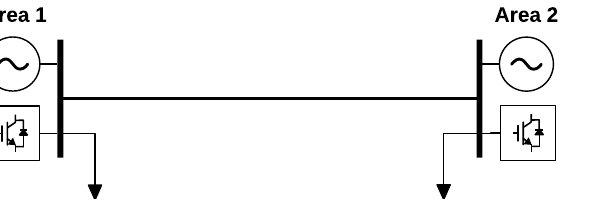
Figure 6. Generic two-area network for the study of the electromechanical oscillations in converter- dominated power